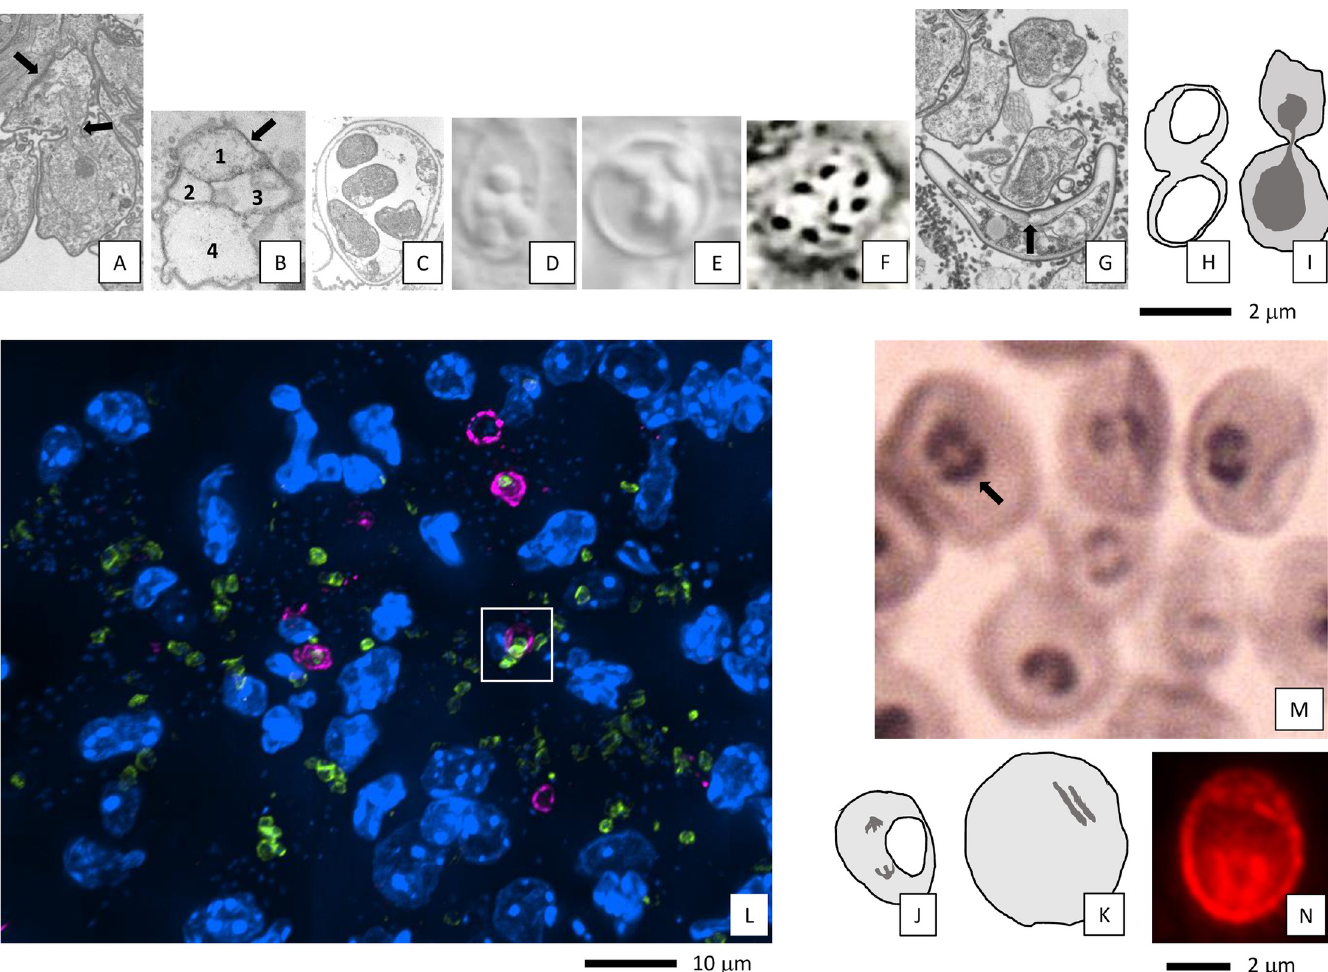
Fig 2. Microscopic observations of Pneumocystis . (A, G) Cushion’s data, electron micrsocopy (except [D] and [E] [differential interference contrast], and [F] [Diff- Quik staining, bright field]). (A) A trophic form tightly interdigitated with the host’s alveolar epithelial pneumocytes type I (top arrow). This trophic form also shows fusion with a second trophic form at the level of the cell membrane as well as possibly at the level of the nuclear membrane (middle arrow). (B) Endogeny with four daughter cells within a trophic form. The daughter cells are numbered on the image. Note the absence of cell wall (arrow). (C, D) Rounded ascopsores within an ascus. (E, F) Elongated and condensed ascopsores within an ascus. (G) Collapsed crescent ascus with rounded trophic forms associated. The latter correspond supposedly to released ascopsores. A rent in the ascus cell wall is highlighted by the arrow. (H) Dividing or mating trophic forms; the white rounded structures are supposedly a vacuole (drawn from the electron microscopic image of Fig 4 of [13]). (I) Supposedly mating trophic forms showing fusion of nuclei in dark gray suggesting karyogamy (from Fig 3 of [13]). (J) Karyokinesis within a trophic form; the spindles poles are in dark gray; the white rounded structure is supposedly a vacuole (from Fig 5 of [9]). (K) Synaptonemal complex shown in dark gray in a young ascus (from Fig 2 of [16]). (L) P . murina cell population from resected infected lungs. Green, anti-p57 surface glycoprotein specific to ascospores; magenta, anti-glucan; blue, DNA stained with DAPI. An ascus putatively releasing ascopsores is shown within the boxed area (adapted from [23]). (M) Parentheses-like structures on P . jirovecii asci. The arrow points to this structure of a single ascus. Grocott’s methenamine silver staining (Institute of Microbiology, Lausanne University Hospital). (N) Ascus stained with an antibody conjugated to Alexafluor 594 raised against 1,3- β glucan featuring a circular structure [15]. Alexafluor 594, fluorescent dye; Diff-Quik, modified Giemsa stain; p57, surface glycoprotein with a molecular weight of 57